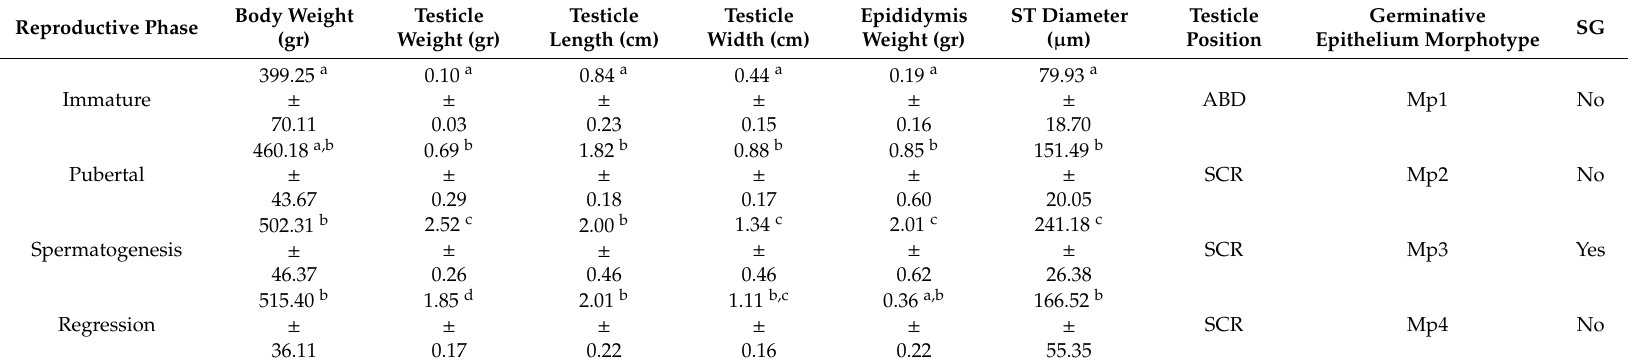
Table 4. Male breeding status according to testicle morphometric characteristics and body